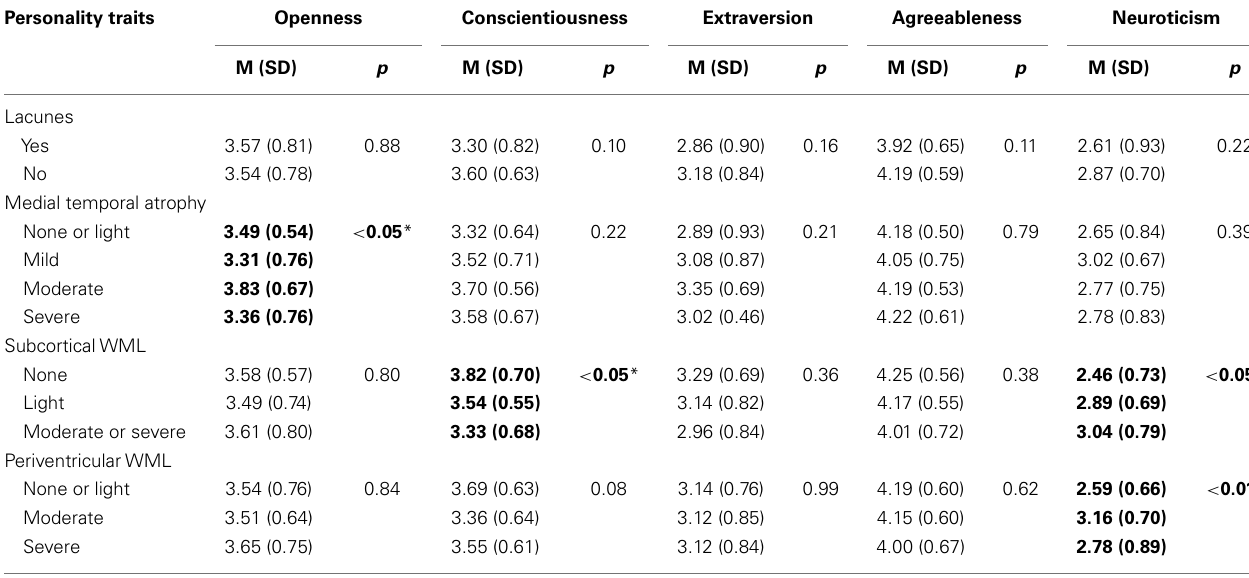
Table 4 | MRI abnormalities according to personality traits